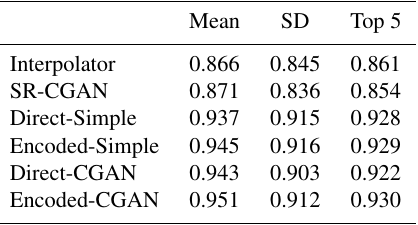
Table 4. Pattern correlations between Ground Truth and six predic- tive models (Interpolator and the CNN-based